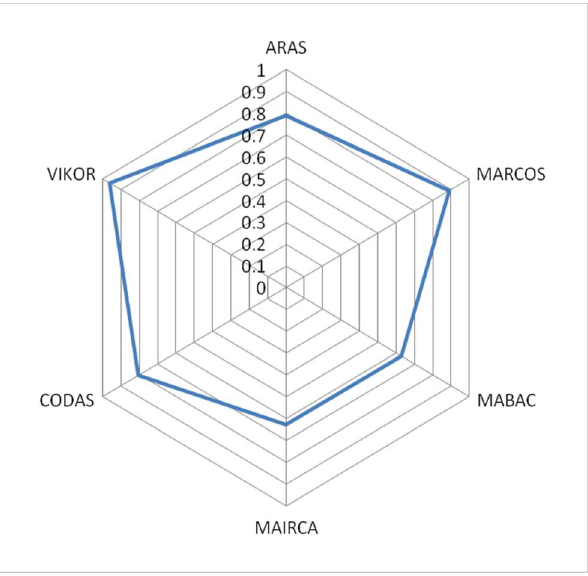
Figure 6. The values of the Spearman’s coefficient of the rank correlations for 6 methods in relation to the initial rank of alternatives.